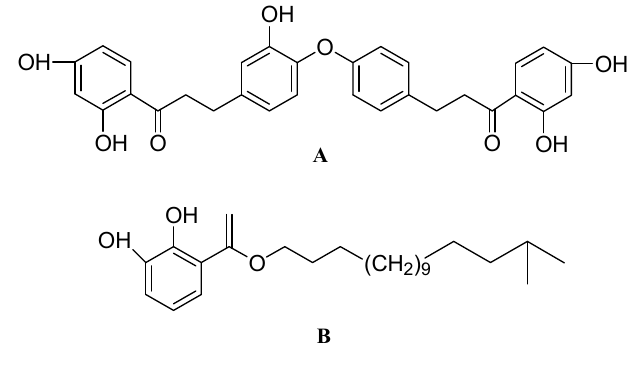
Figure 8. The molecular structures of littorachalcone ( A ) and gentiside C ( B